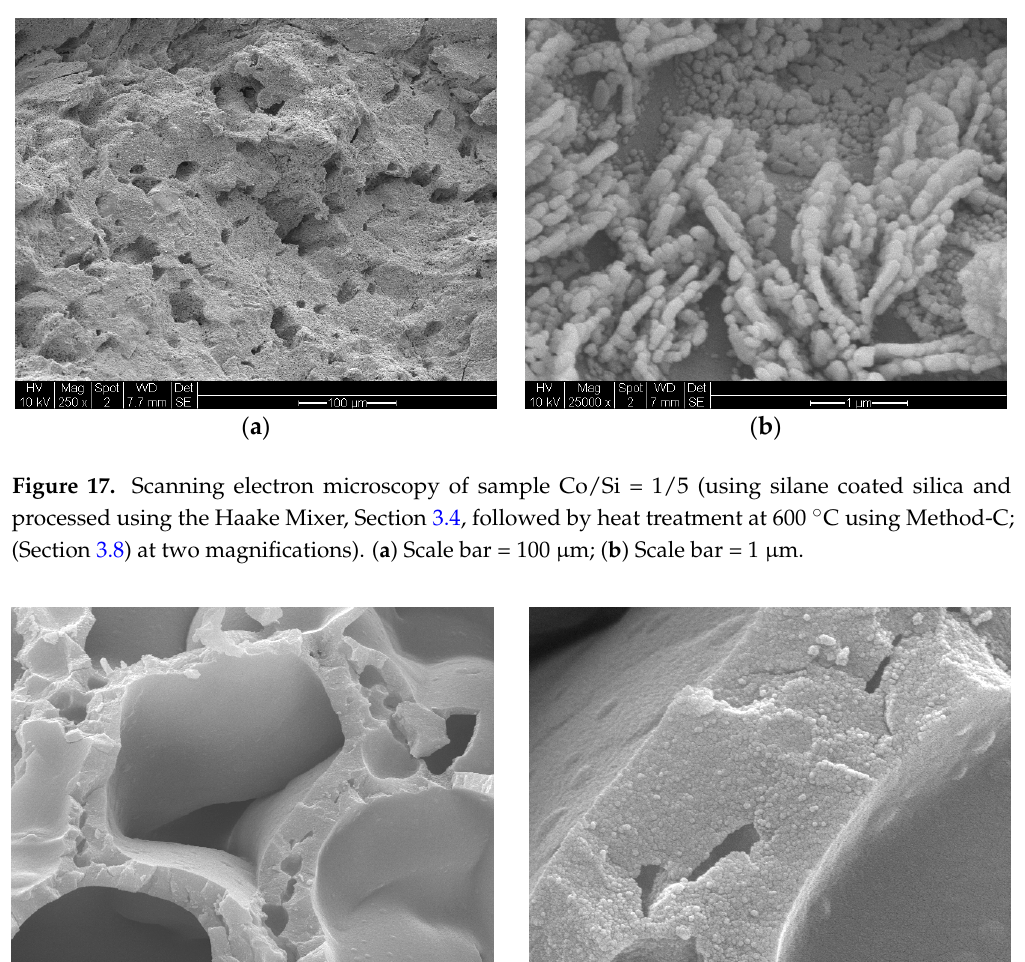
Figure 17. Scanning electron microscopy of sample Co/Si = 1/5 (using silane coated silica and processed using the Haake Mixer, Section 3.4, followed by heat treatment at 600 °C using Method ‐ C; (Section 3.8) at two magnifications). ( a ) Scale bar = 100 μ m; ( b ) Scale bar = 1 μ m.